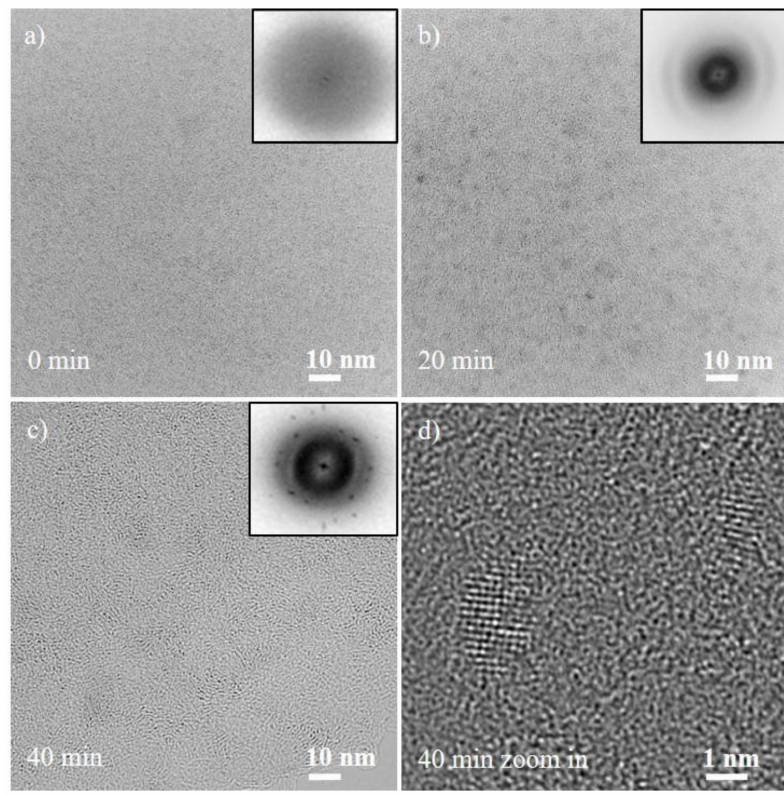
Figure 1. Results of the in situ TEM crystallization experiment for dc-sputtered multinary Cr-Mn-Fe-Co-Ni NPs transferred on a carbon coated gold grid from the IL. ( a ) shows amorphous as-deposited NPs. ( b ) and ( c ) display TEM images and FFT patterns (shown as insets) after 20 and 40 min electron beam illumination and the resulting crystallized NPs. ( d ) HRTEM image of multinary NPs showing lattice fringes. For better visibility, the contrast in the FFT patterns is